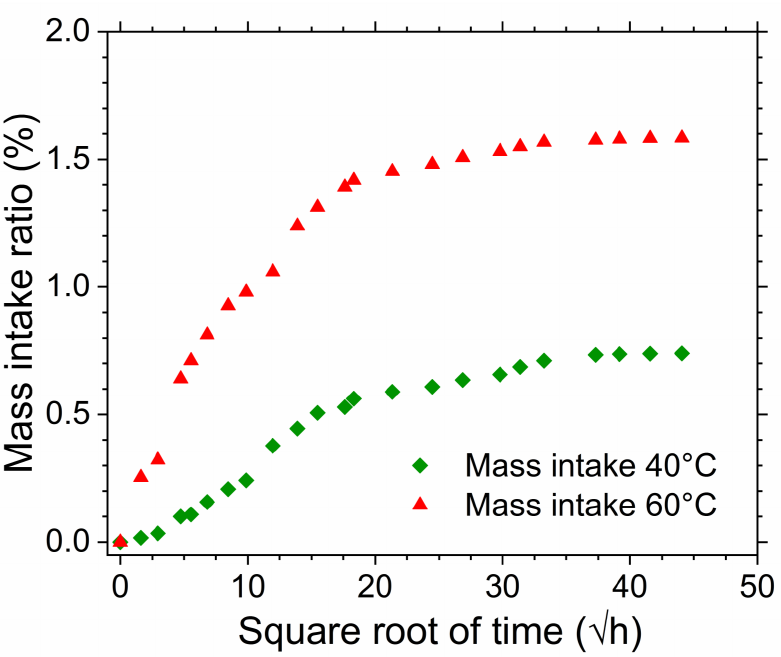
Figure 2. Moisture absorption of composite travellers (UD) immersed in 40 ◦ C and 60 ◦ C